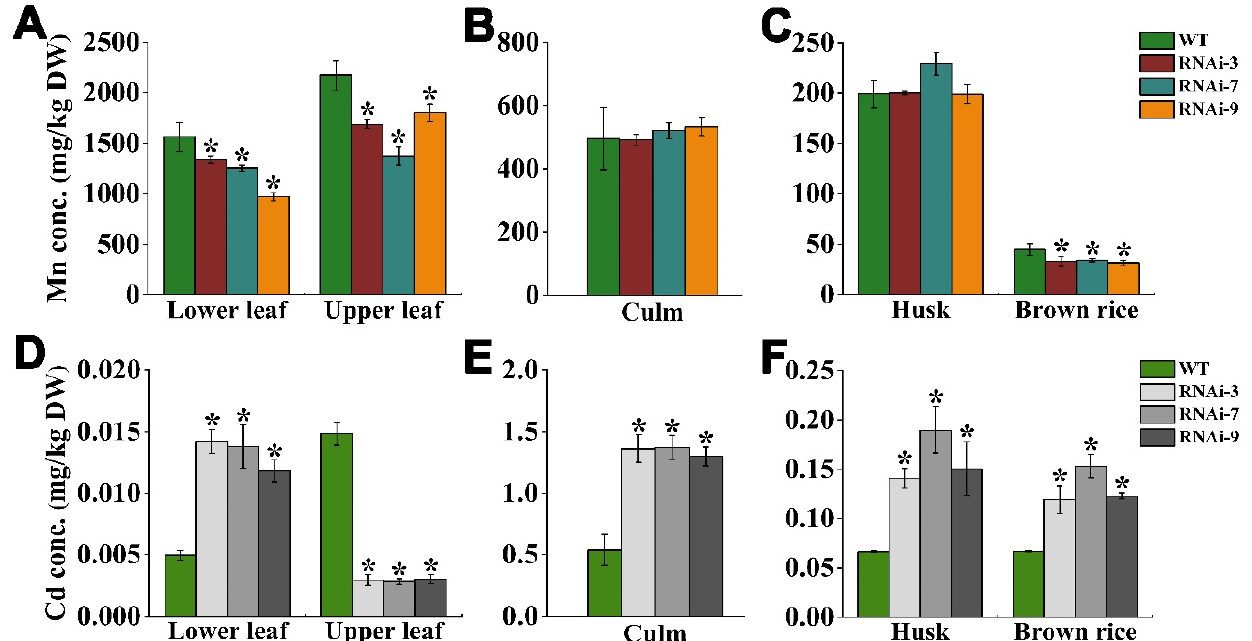
Figure 8. Mn and Cd concentrations in the tissues/organs of RNAi and wild-type (WT) plants at the mature stage. ( A – C ) Rice plants were grown in normal soil (without Cd contamination) and ( D – F ) in Cd-contaminated soil throughout the lifespan. When rice was ripe, total Mn and Cd concentrations in the lower leaves (three basal leaves), upper leaves (three top leaves) including leaf blade and sheath, culm, and grains were measured. Bars indicate the means ± standard deviations of at least three independent biological replicates. Asterisks indicate that the mean values of three replicates are significantly different between WT and RNAi plants ( p < 0.05).